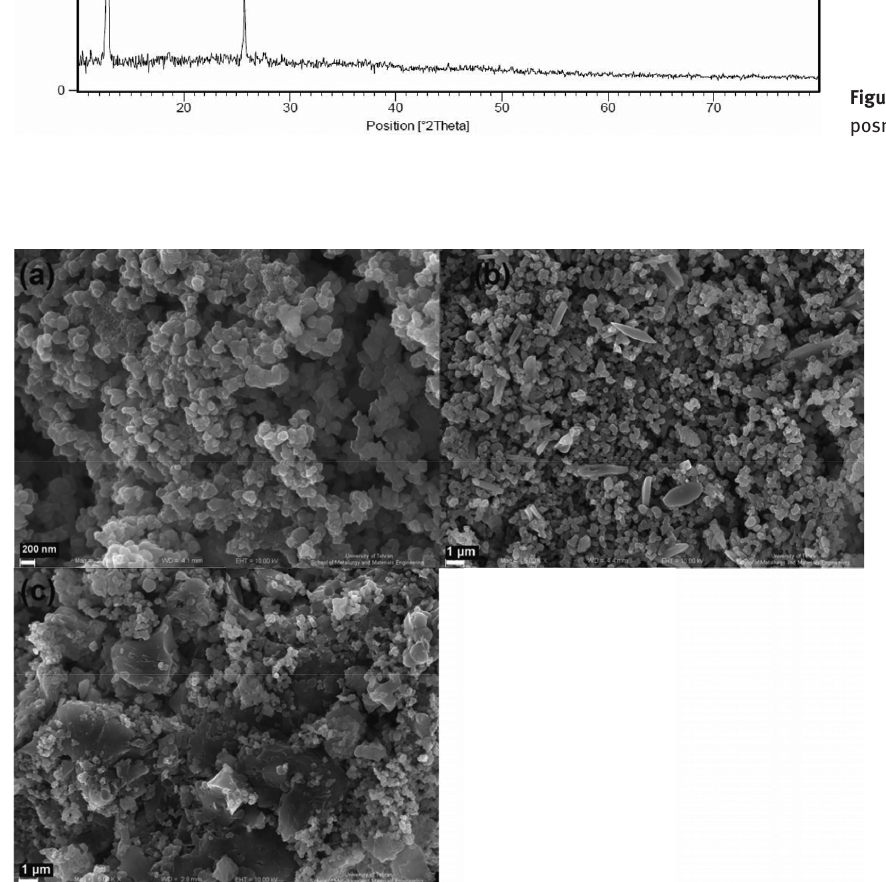
Figure 3: SEM of posnjakite nanopar- ticles in 20 min: (a) 600, (b) 750 and (c) 900